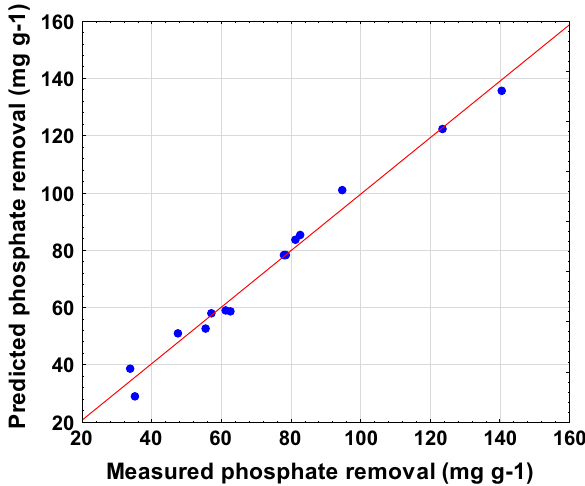
Fig. 3 Plot of the measured and model predicted values of the response variable